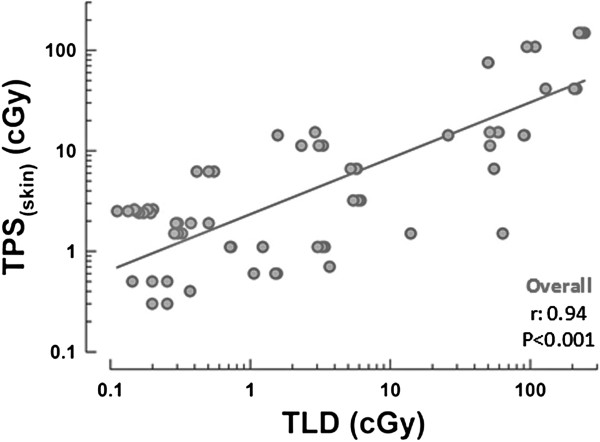
Scatter plot of correlation between TLD and TPS[skin]-estimated doses. Scatterplot of relationship between TPSskin and TLD values. r: Pearson correlation coefficient; p: statistical significance.